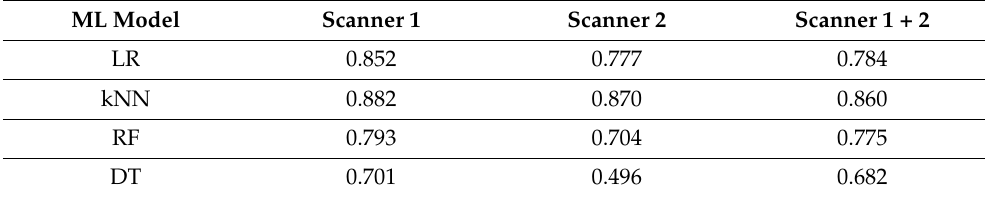
Table 4. Predictive efficiency (AUC) of ML models for scanner 1, scanner 2 and both scanners